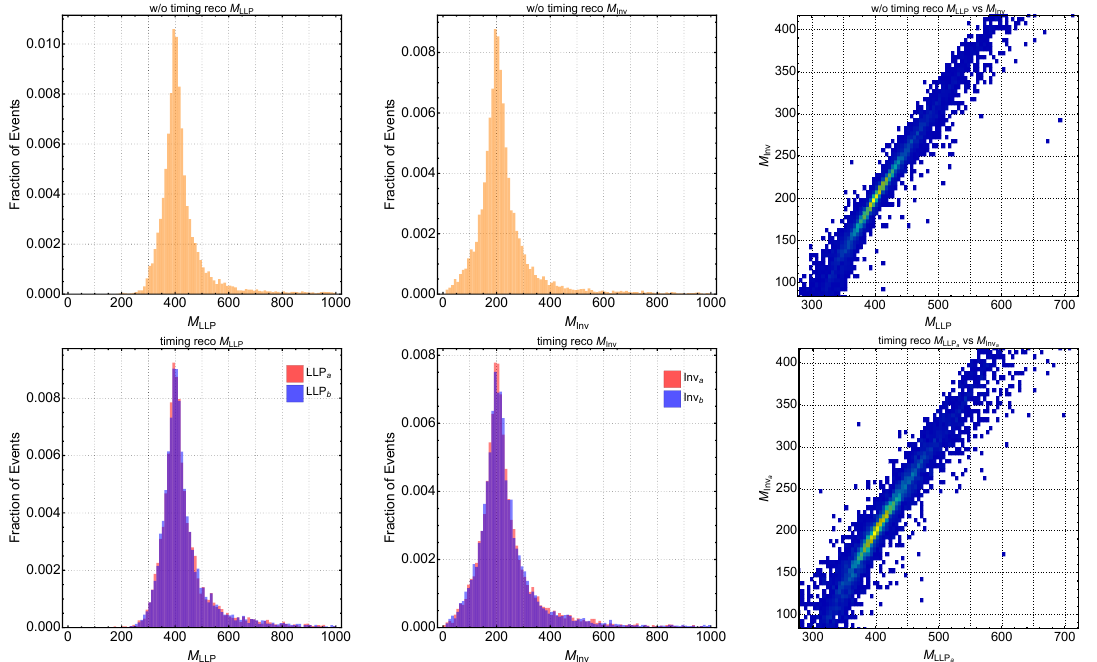
Figure 3 . Mass reconstruction without timing information (top) and with timing information (bottom) for M LLP = M LLP = 400 GeV, M Inv = M Inv = 200 GeV. (Left) LLP mass reconstruc- a a b b tion; (Center) Invisible particle mass reconstruction. Red and blue color indicate each decay chain; (Right) Invisible mass vs. LLP mass distributions. All histograms were (cid:12)lled with 10k events unless otherwise noted.